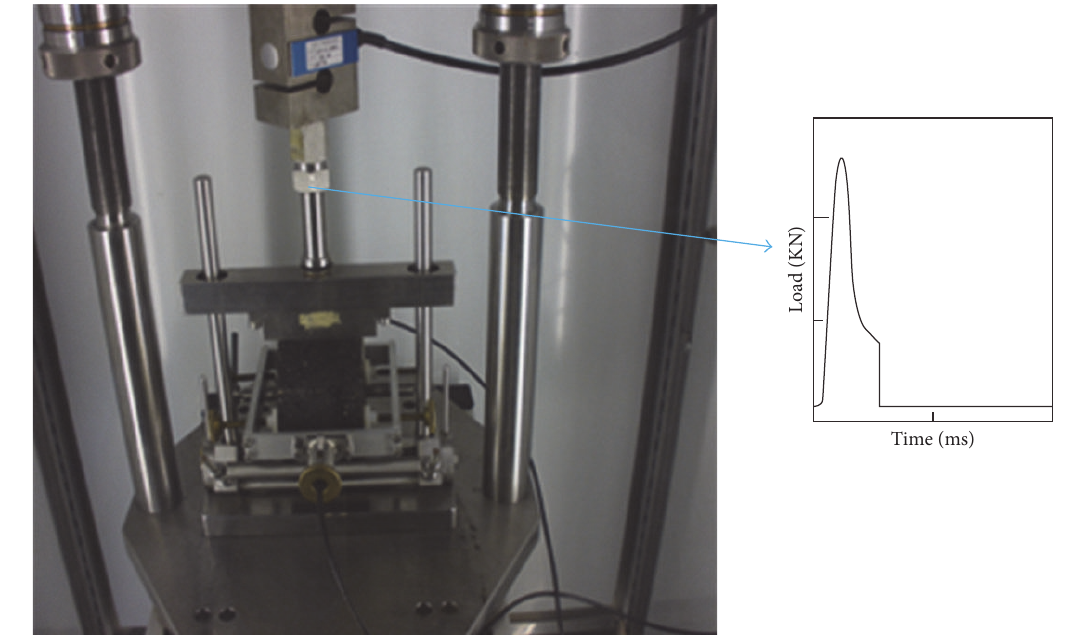
Figure 6: Indirect tensile stiffness modulus test.